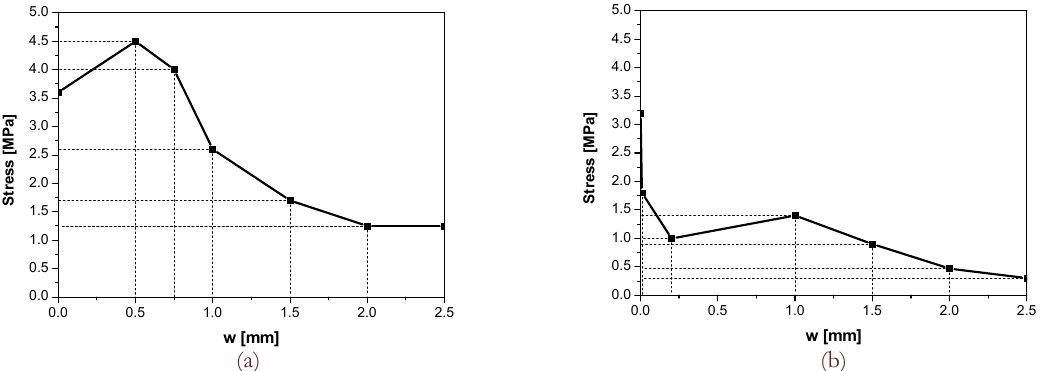
Figure 13: Numerical uniaxial stress – crack width relationship, σ – w , obtained from inverse analysis for: (a) θ = 0 ° and (b) θ = 90 ° . Comparison of